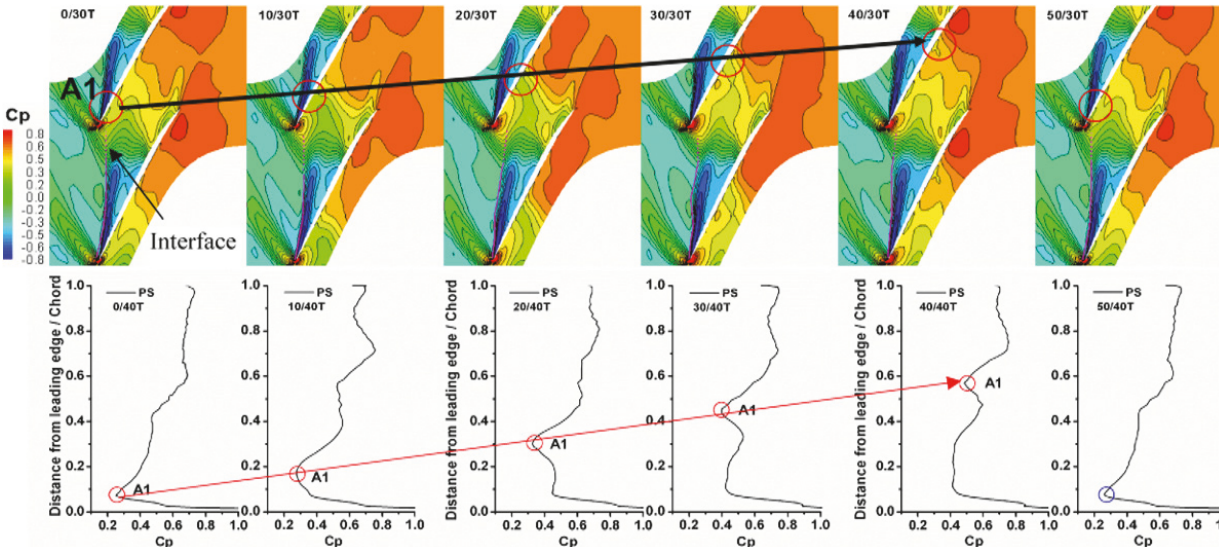
Figure 5: Snapshots of 6 instantaneous moments during one period of TLD oscillation for Rotor 67 ([13]). “T” represents the time interval to store the data set by the time-accurate CFD solver. Figure reproduced from DU et al. (2010).